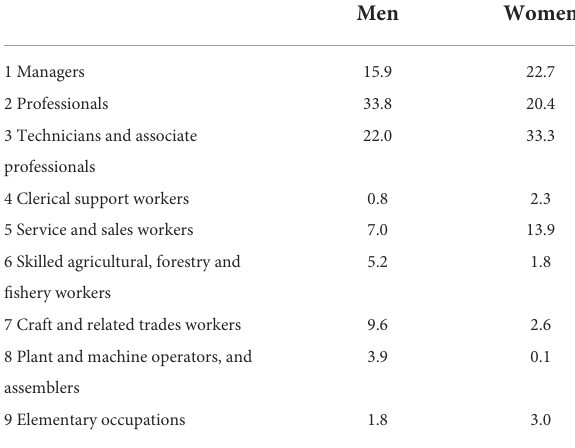
TABLE 1 Occupations of older entrepreneurs (ISCO Classification) by